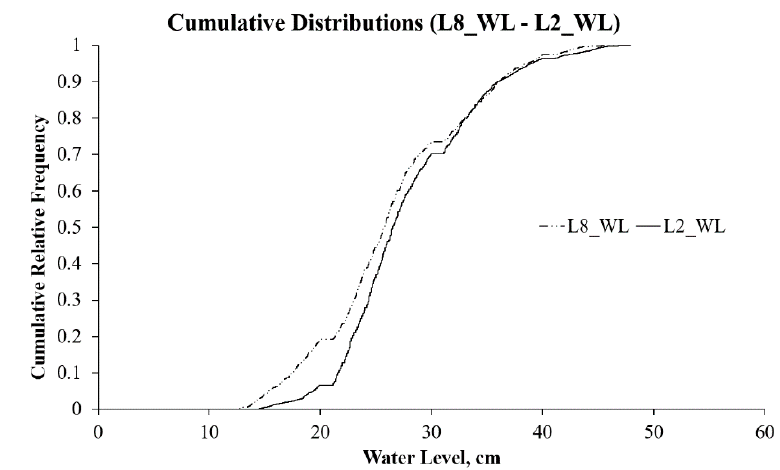
Figure 10. Cumulative distributions for L2_WL and L8_WL data.